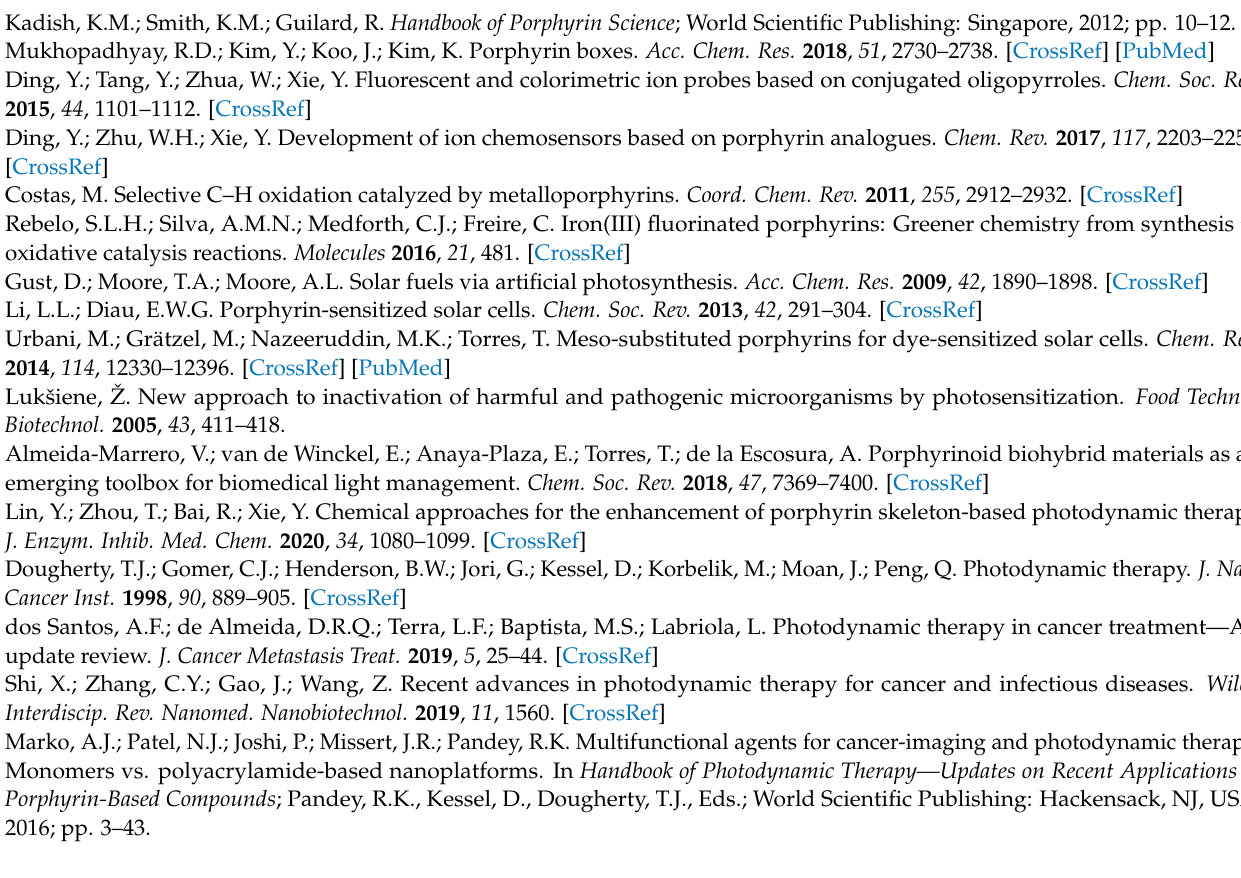
NMR spectra of 8 in CDCl 3 ; Figure S4. The 1 H, 11 B NMR spectra of 9 in CDCl 3 ; Figure S5. The 1 H and 11 B NMR spectra of 11 in CDCl 1 H and 11 B NMR spectra of 12 in CDCl 3 ; Figure S6. The 3 ; Figure S7. The 1 H and 11 B NMR spectra of 17 in CDCl 1 H and 11 B NMR spectra of 18 in CDCl 3 ; Figure S8. The 3 ; Figure S9. The 1 H and 11 B NMR spectra of 19 in CDCl 3 ; Figure S10. The 1 H, 11 B and 19 F spectra of 20 in CDCl 3 ; Figure S11. The 1 H, 11 B NMR spectra of 21 in CDCl 3 ; Figure S12. The 1 H and 11 B NMR spectra of 24 in (CD 3 ) 2 CO; Figure S13. The 1 H and 11 B NMR spectra of 25 in (CD 3 ) 2 CO; Figure S14. Dark cytotoxicity of compounds 8 , 9 , 17 , 18 and 24 ; Figure S15. Photoinduced cytotoxicity of compounds 8 , 9 , 17 , 18 and 24